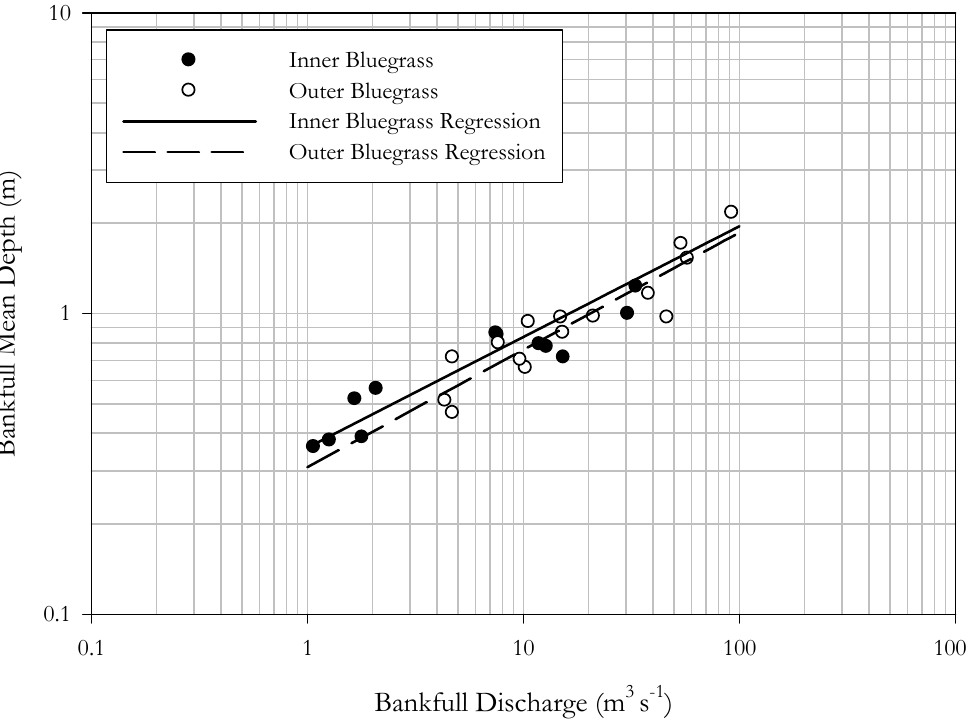
Figure 6. Bankfull mean depth vs . bankfull discharge for the Inner Bluegrass and Outer Bluegrass